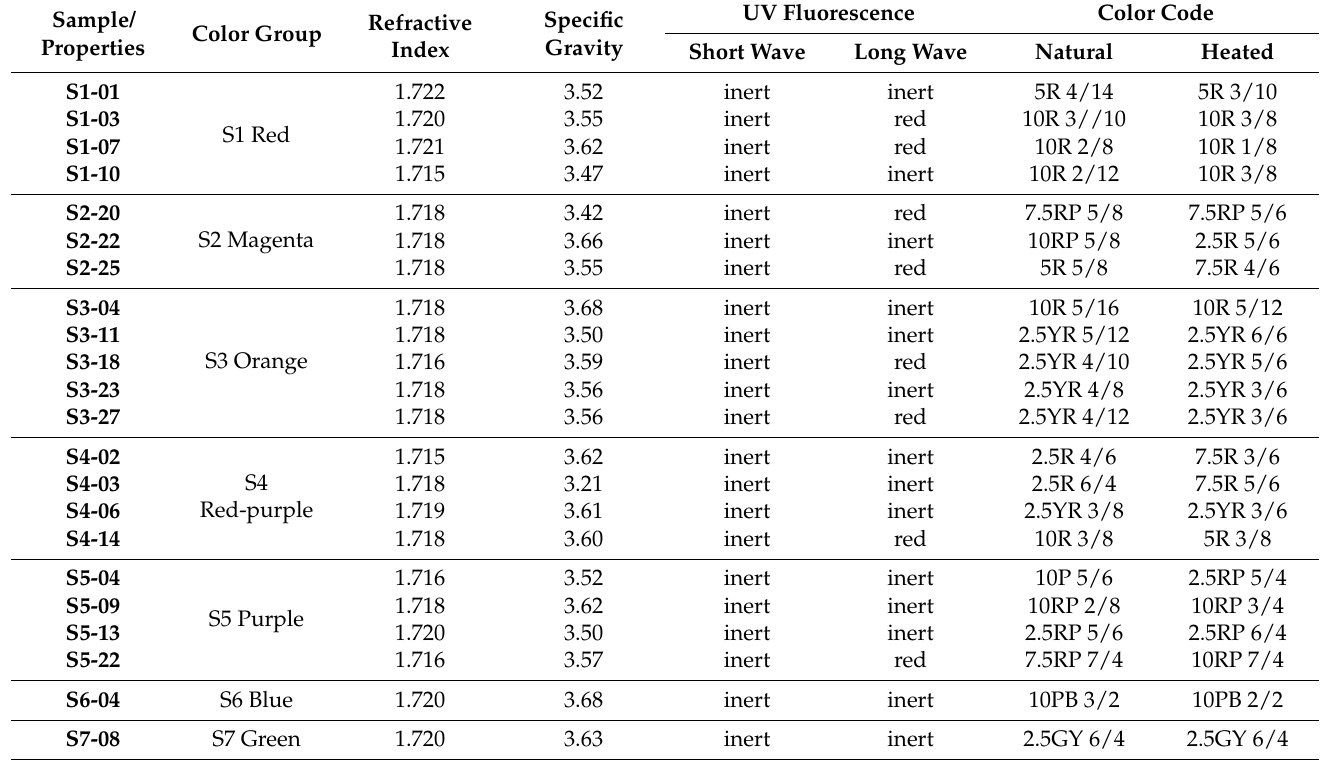
Table 2. Physical properties of spinel